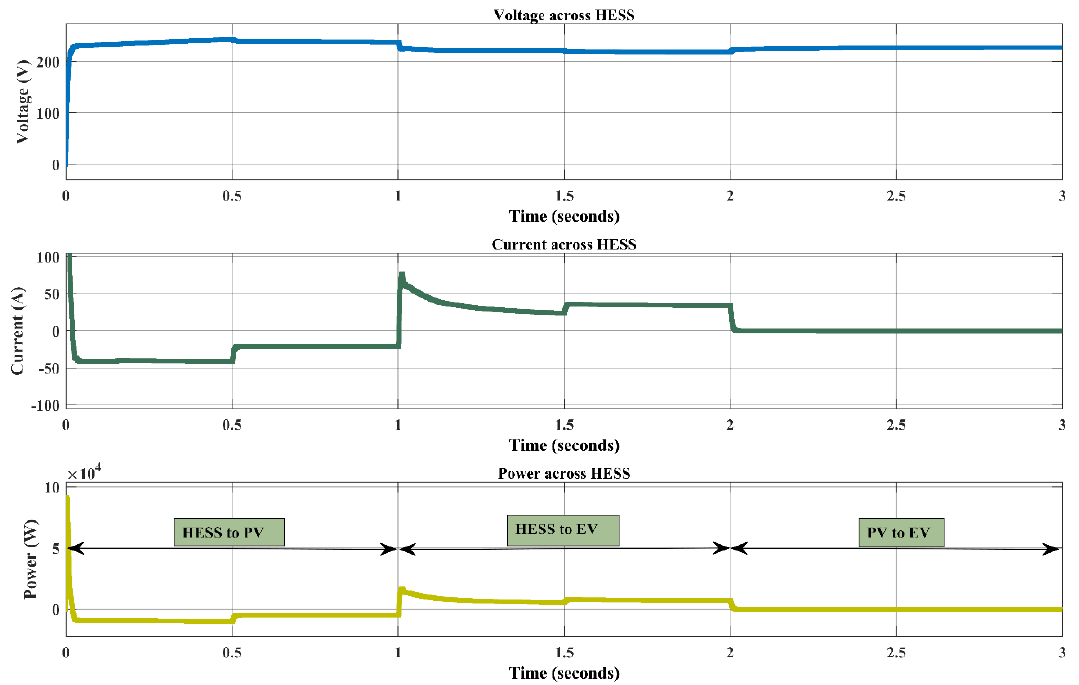
Figure 20. Hybrid energy storage system operates for different conditions; Mode_1: PV to HESS, Mode_2: HESS to EV; and Mode_3: PV to EV charging station.